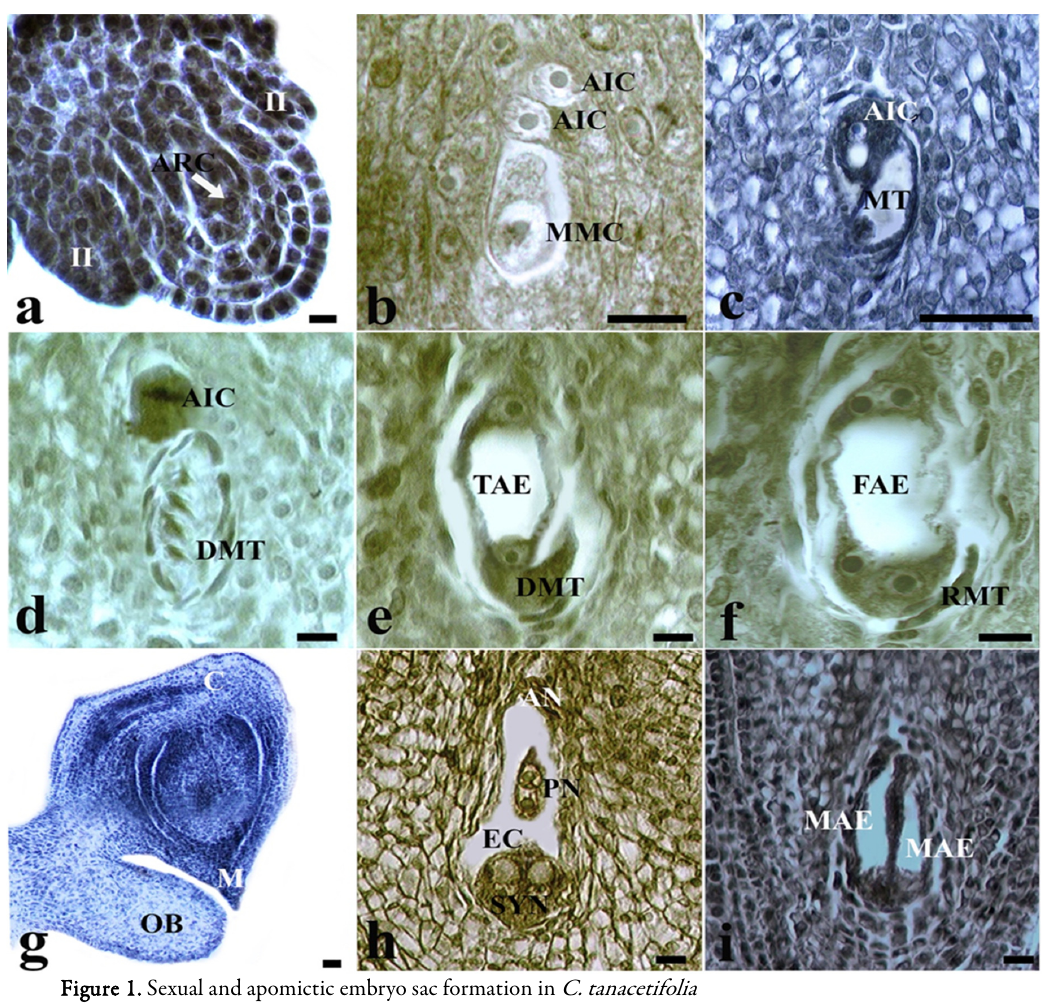
Figure 1. Sexual and apomictic embryo sac formation in C. tanacetifolia a Archesporial cell, b Megaspore mother cell and aposporic initial cells, c Vacuolated aposporic initial cell and linear megaspore tetrad, d Metaphase at first mitosis of aposporic initial cell and degeneration of megaspore tetrad, e Two nucleated aposporic embryo sac and degenerating megaspore tetrad in the same ovule, f Four nucleated aposporic embryo sac and the remnant of megaspore tetrad, g Mature anatropous ovule, h Eight nucleated mature aposporic embryo sac, i Two mature aposporic embryo sac in a mature ovule. ARC: Archesporial cell, II: Inner integument, AIC: Aposporic initial cell, MMC: Megaspore mother cell, MT: Megaspore tetrad, TAE: Two nucleated aposporic embryo sac, DMT: Degenerated megaspore tetrad, FAE: Four nucleated aposporic embryo sac, RMT: Remnant of megaspore tetrad, OB: Obturator, C: Chalaza, M: Micropyle, AN: Antipodal cell, PN: Polar nuclei, EC: Egg cell, SYN: Synergids, MAE: Mature aposporic embryo sac. Bar: 10